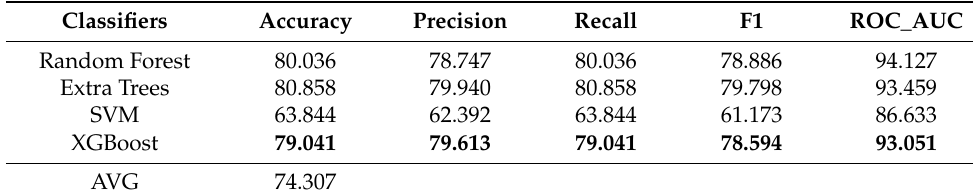
Table 9. Experimental Results using S1HT2 with 3157 features.